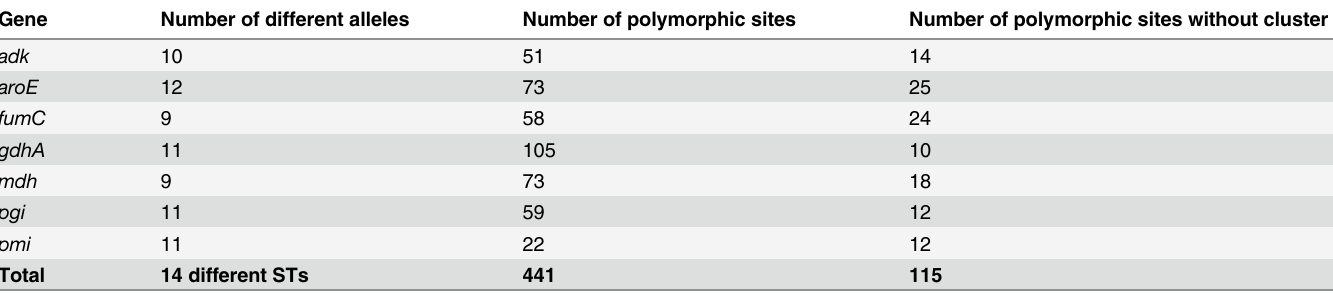
Table 3. Maximum number of alleles and polymorphic sites per gene